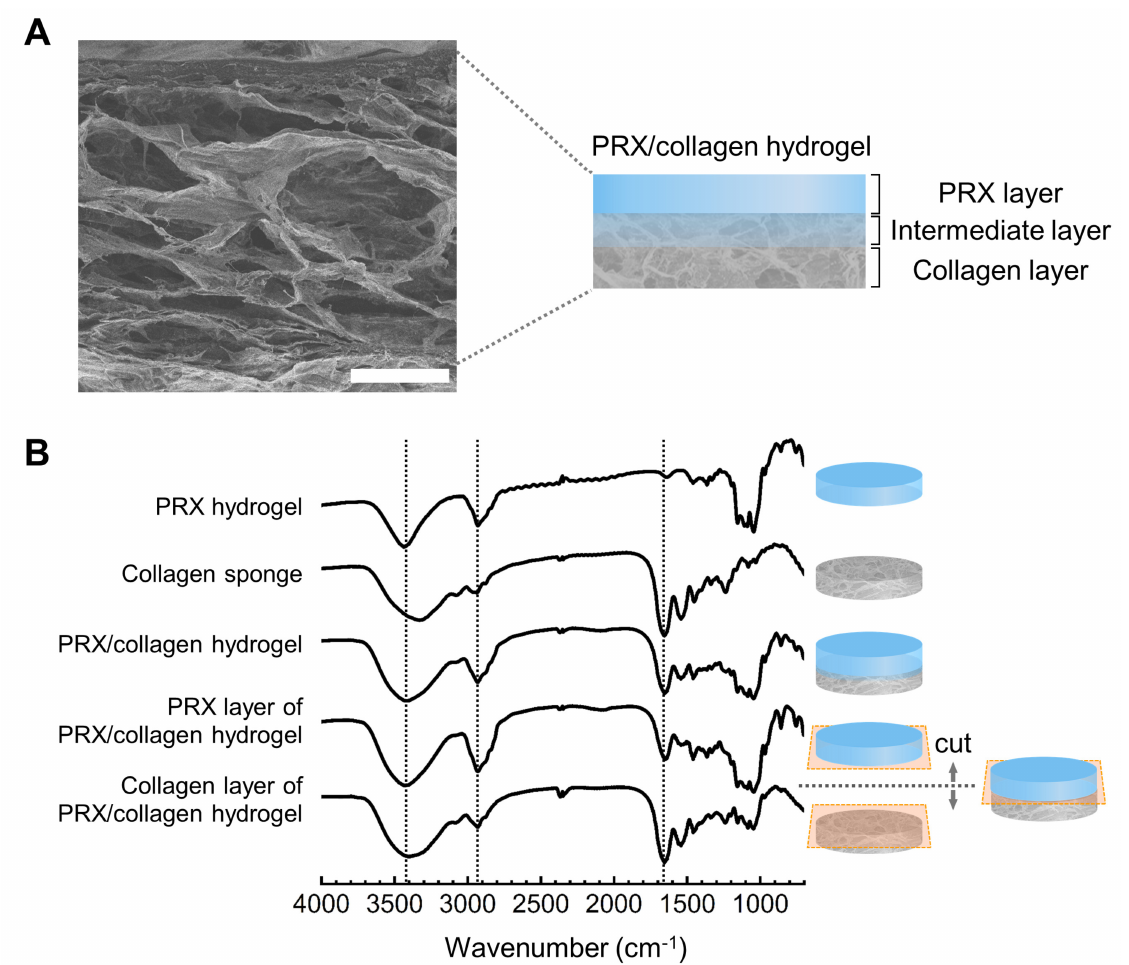
Figure 4. ( A ) SEM images of polyrotaxane (PRX)/collagen hydrogels (scale bar: 200 µ m). ( B ) FT-IR spectra of PRX hydrogels, PRX/collagen hydrogels, the PRX layer in PRX/collagen hydrogels, the collagen layer in PRX/collagen hydrogels, and collagen